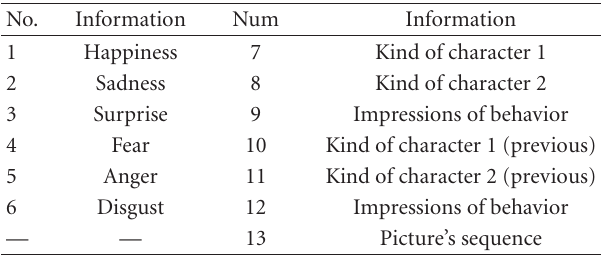
Table 1: Information on story scene. Table 2: Transformation image